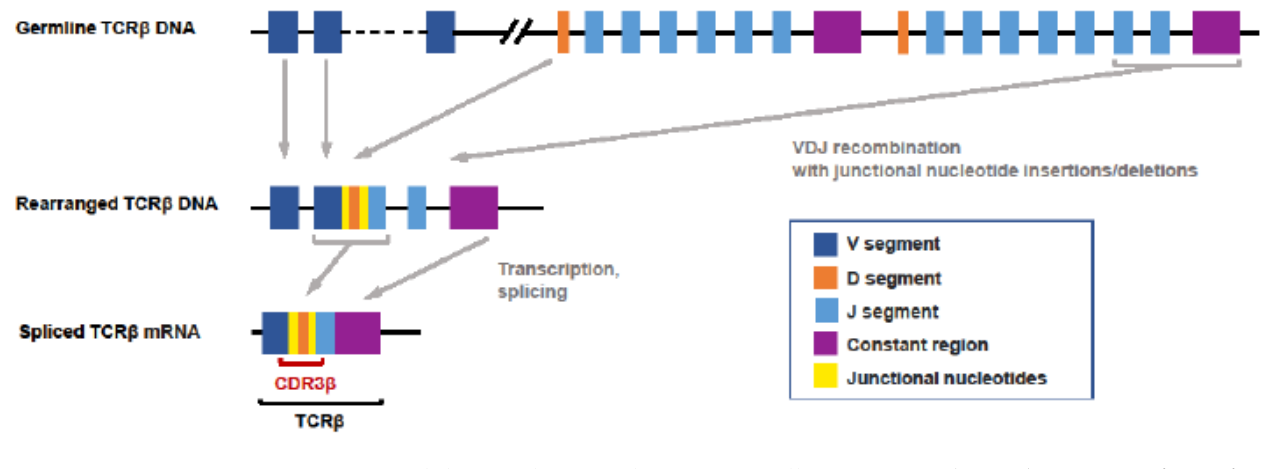
Figure 1. V(D)J recombination determines T-cell receptor specificity. The TCR specificity of αβ T cells is determined by the unique V(D)J recombination events that occur during the development of each T cell. During this process, V, D and J gene segments are randomly selected and are spliced together on the β chain, while the α -chain rearrangement of the V–J gene segments occurs in a similar process. During this process, the random addition or deletion of nucleotides can occur at segment junctions. The complementarity-determining region 3 (CDR3) encoded by sequences located in the V(D)J junction has the greatest diversity and is what determines the antigen specificity of each TCR. TCR β : T-cell receptor beta; CDR3 β : the gene sequence encoding the complementarity-determining region 3 of the TCR beta chain.